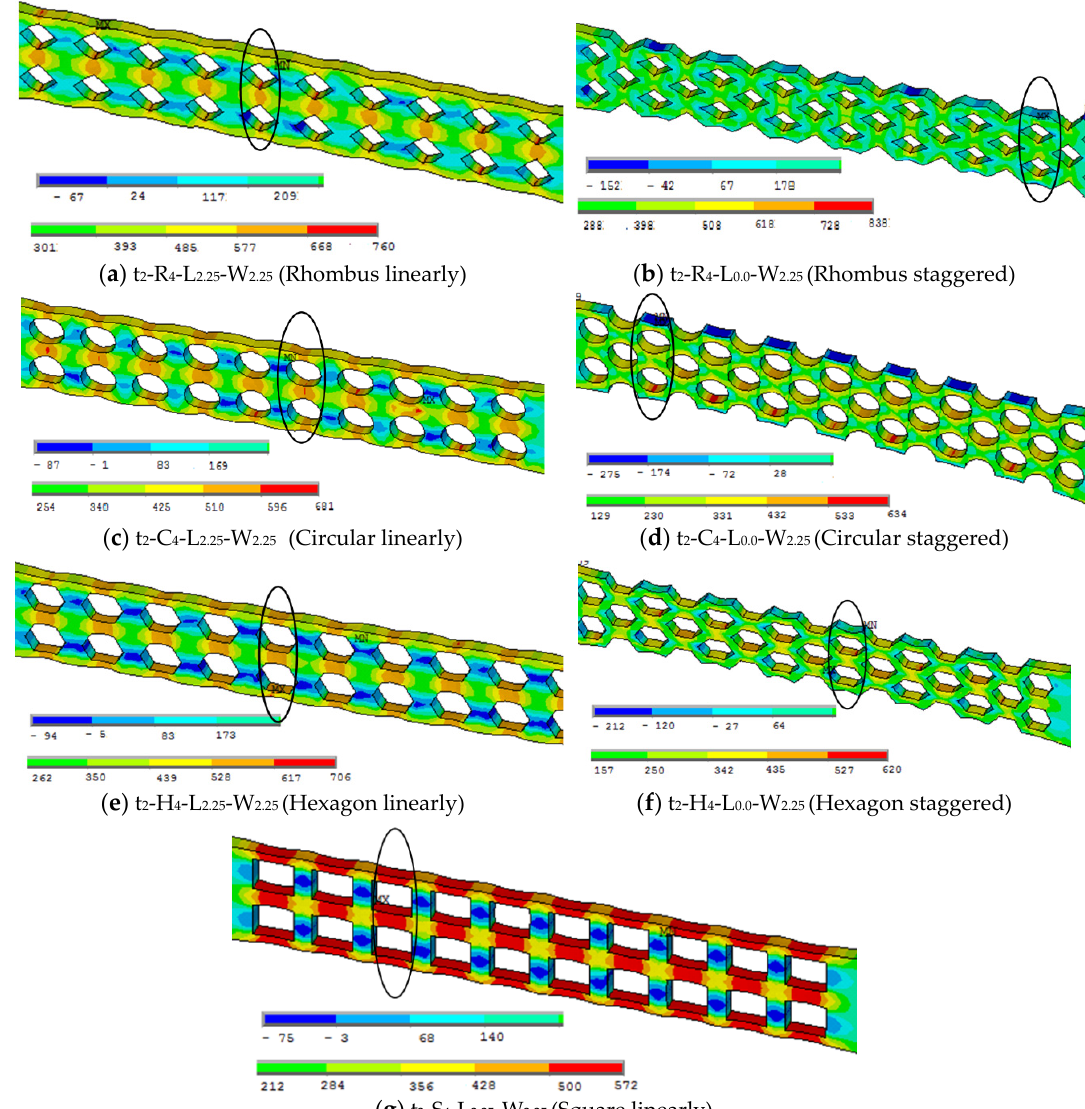
Figure 8. Pattern of maximum ultimate stresses of steel sheets perforated for longitudinal and staggered shapes (MPa).